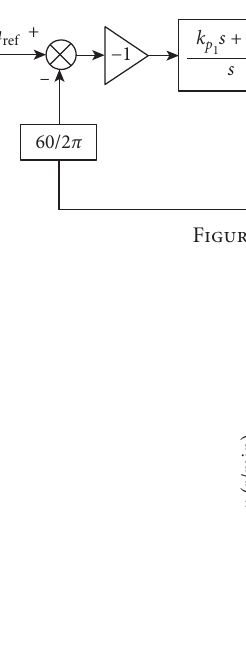
P is changed. ref